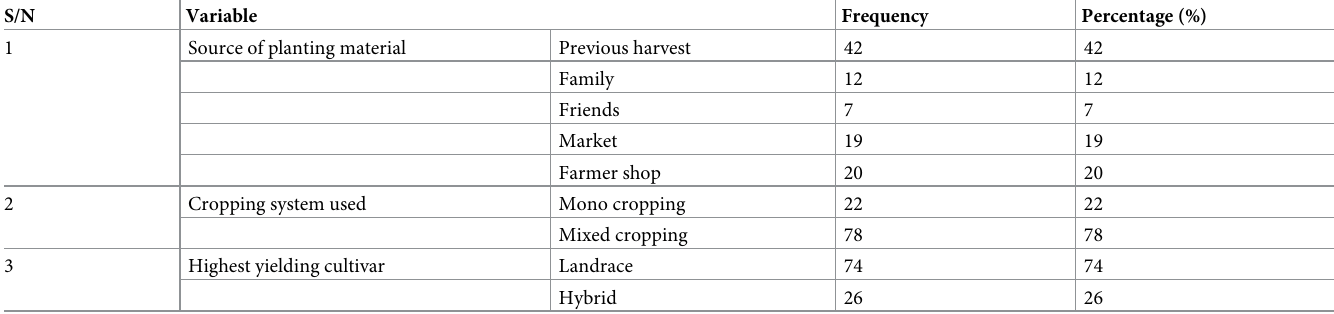
Two cultivated landraces were identified, that is, the “3 months” (annual) landrace and the “6 months” (biennial)